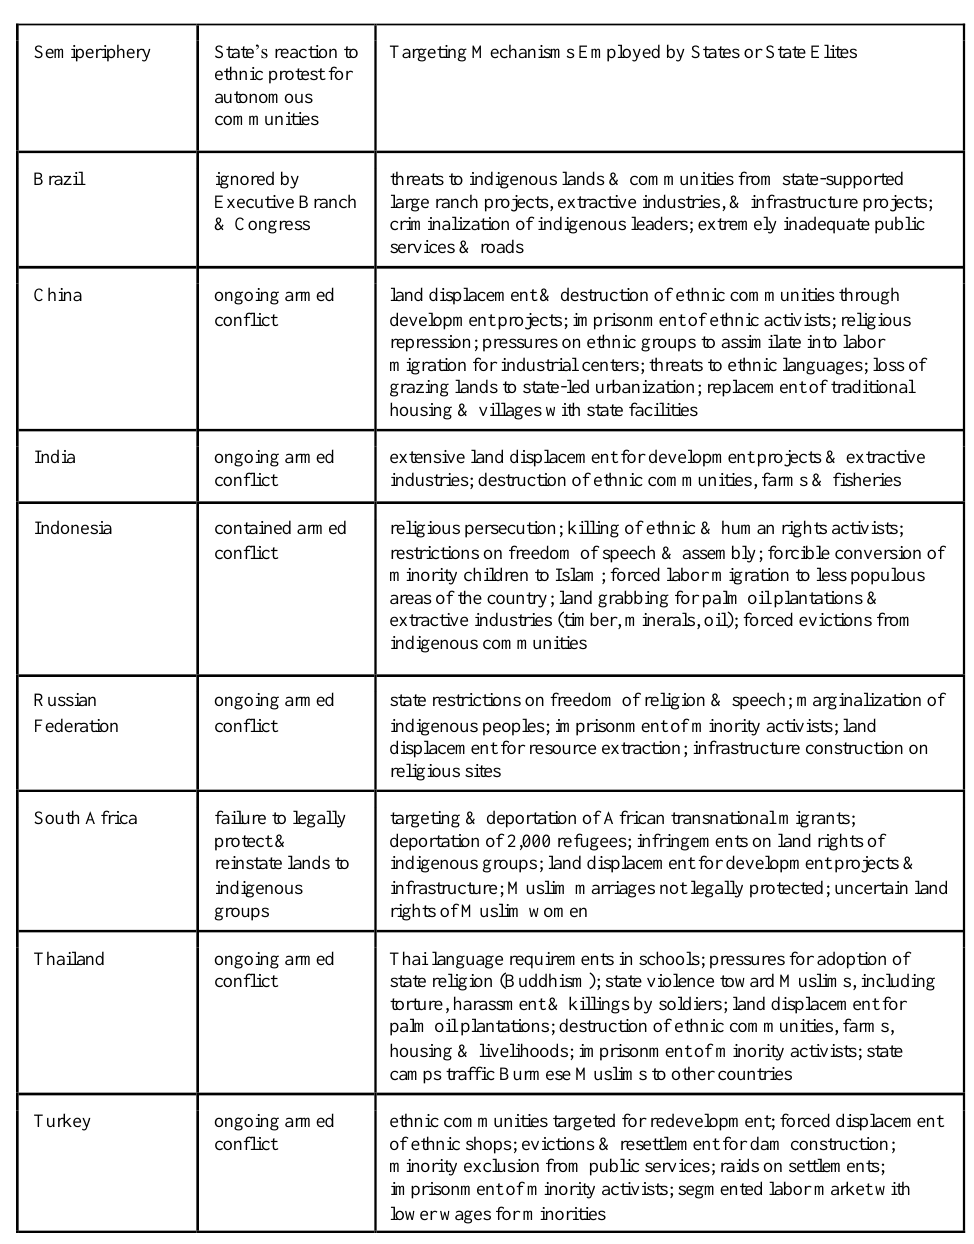
Table 8. State Actions against Ethnic Minorities in Selected Semiperipheries, 2015